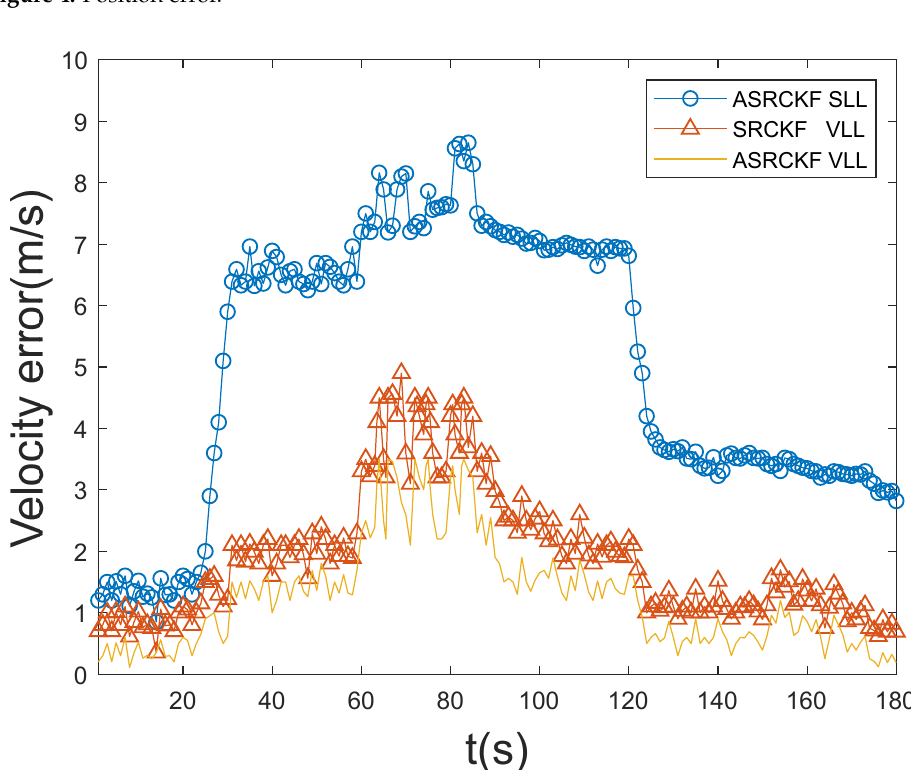
Figure 4. Position error.